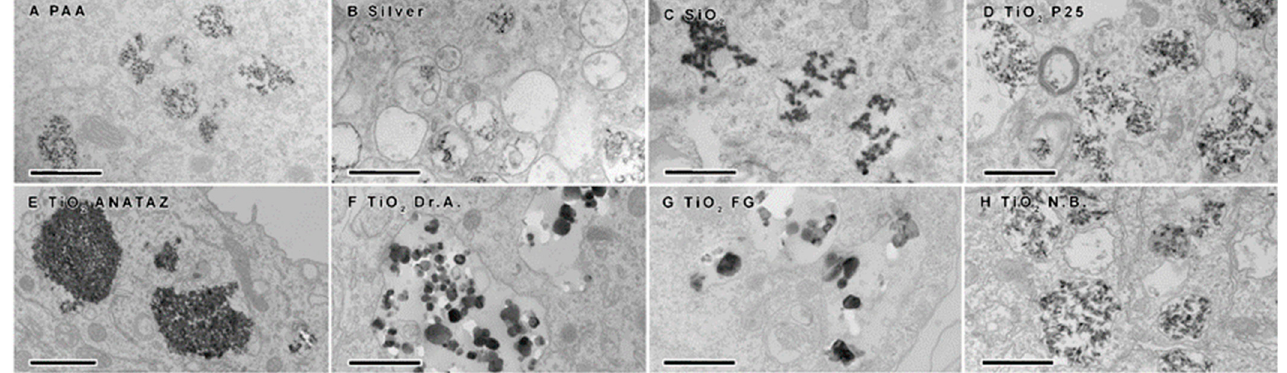
Figure 5. Transmission electron microscopy analysis of differentiated THP-1 cells following 24 h incubation with 50 µg mL − 1 (25 µg mL − 1 for silver NPs) of ( A ) polyacrylic acid (PAA)-coated magnetic NPs, ( B ) silver NPs, ( C ) engineered SiO 2 NPs, ( D ) TiO 2 P25, ( E ) TiO 2 ANATAZ, ( F ) TiO 2 DrA, ( G ) TiO 2 food-grade (FG), and ( H ) TiO 2 N.B. NPs. Scale bars correspond to 600 nm.